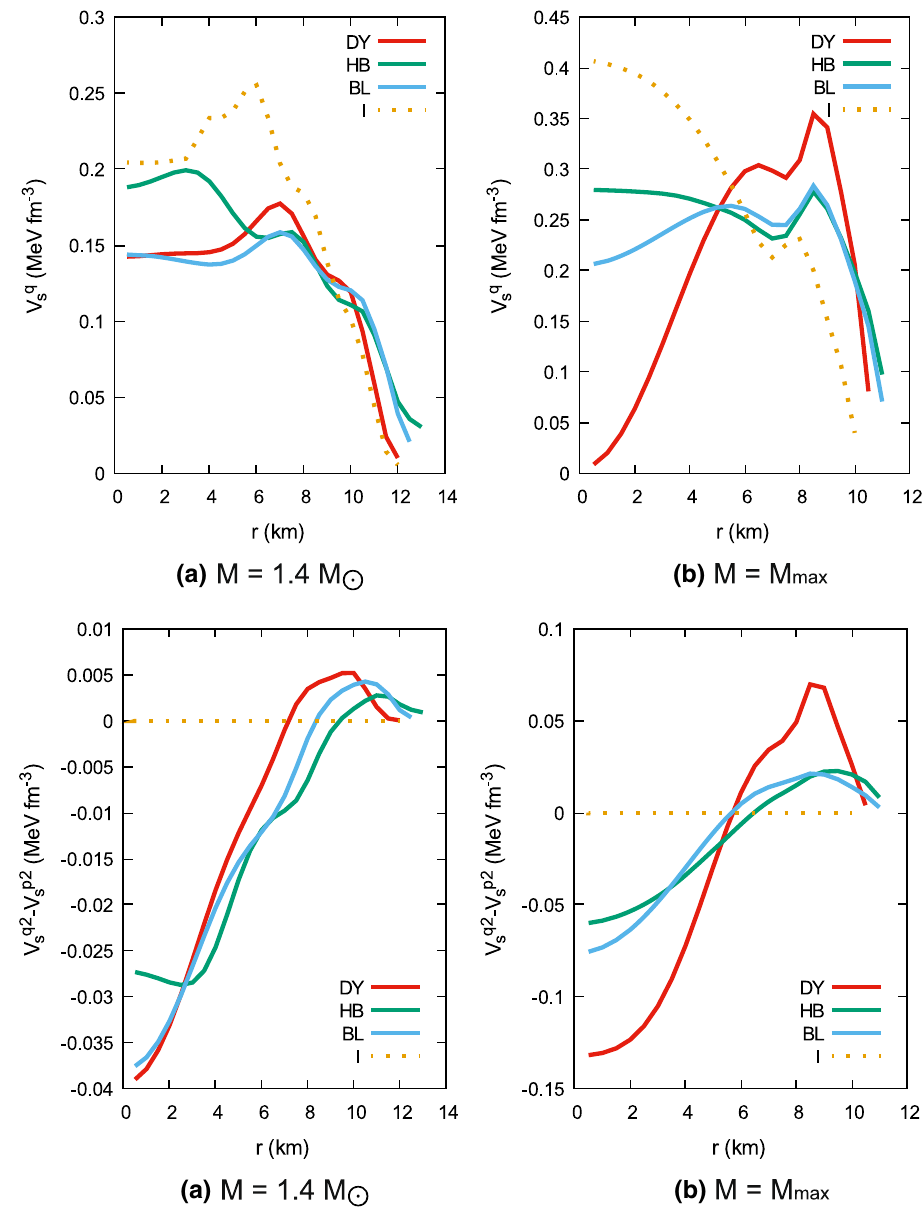
anisotropic models NSs and its isotropic (I) for M = 1 . 4 M (cid:6) and M = M max